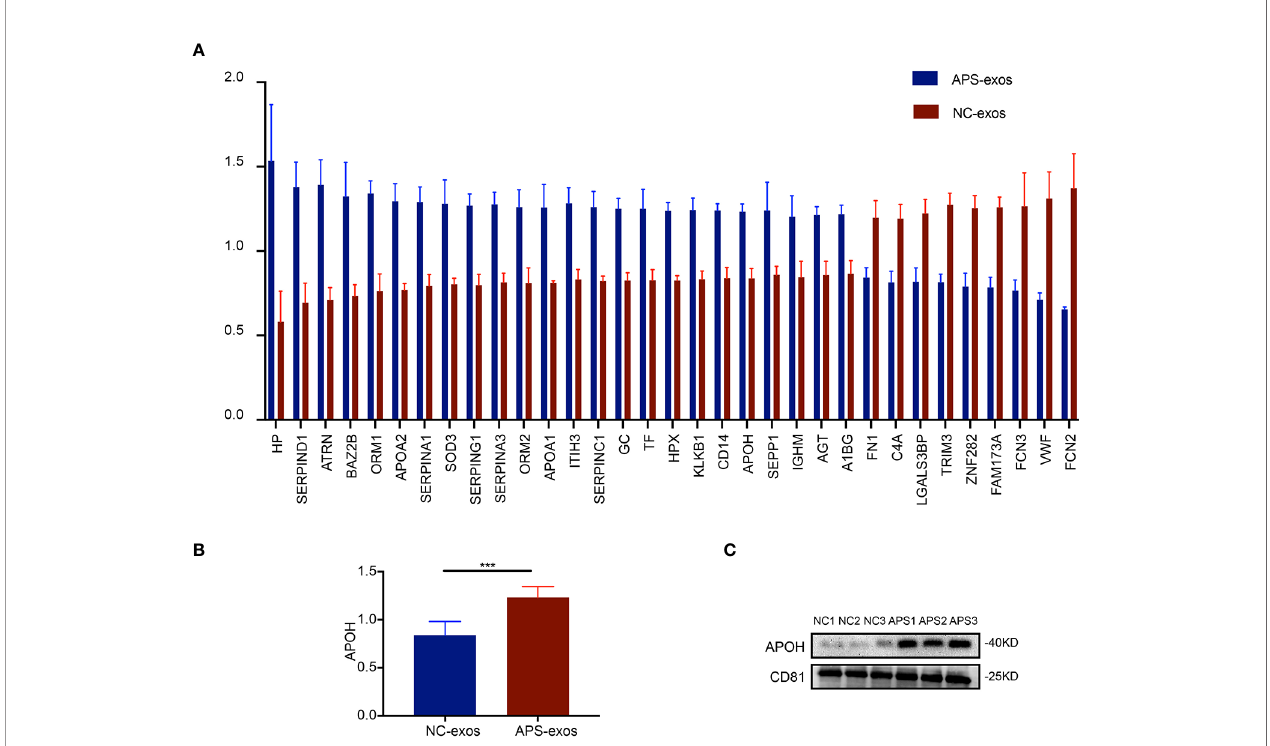
FIGURE 3 | Proteomic analysis results. (A) A total of 293 proteins were identi fi ed from the two groups. Twenty-seven upregulated proteins and nine downregulated proteins were identi fi ed by quantitative proteomics tandem mass tag analysis of antiphospholipid syndrome-exosomes (APS-exos) and normal control (NC)-exos. Mean ± SEM (36 proteins were signi fi cantly different, P < 0.05 by t test). (B) The difference in APOH expression between the two groups shown by proteomic analysis (P = 0.000 by t test). (C) Clinical validation showed that the level of APOH was signi fi cantly higher in APS-exos than that in NC-exos. “ *** ” means P = 0.000 by t